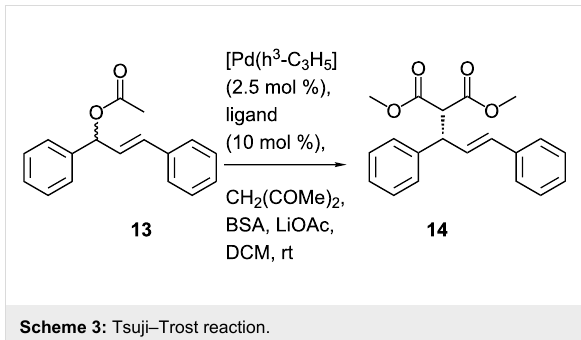
Scheme 3: Tsuji–Trost reaction.